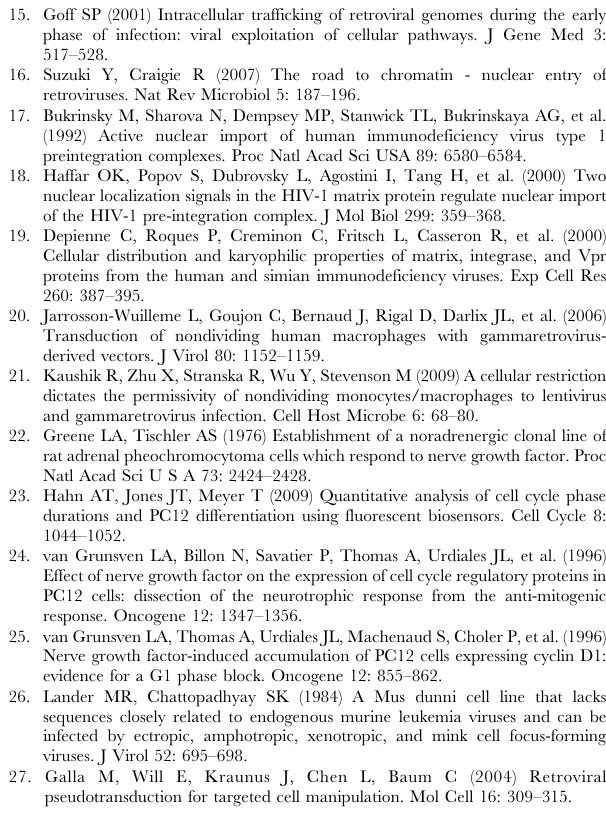
Figure S1 Schematic depiction of the replication-com- petent GFP-expressing proviral genome and the pack- ageable retroviral vectors employed in these studies. A .